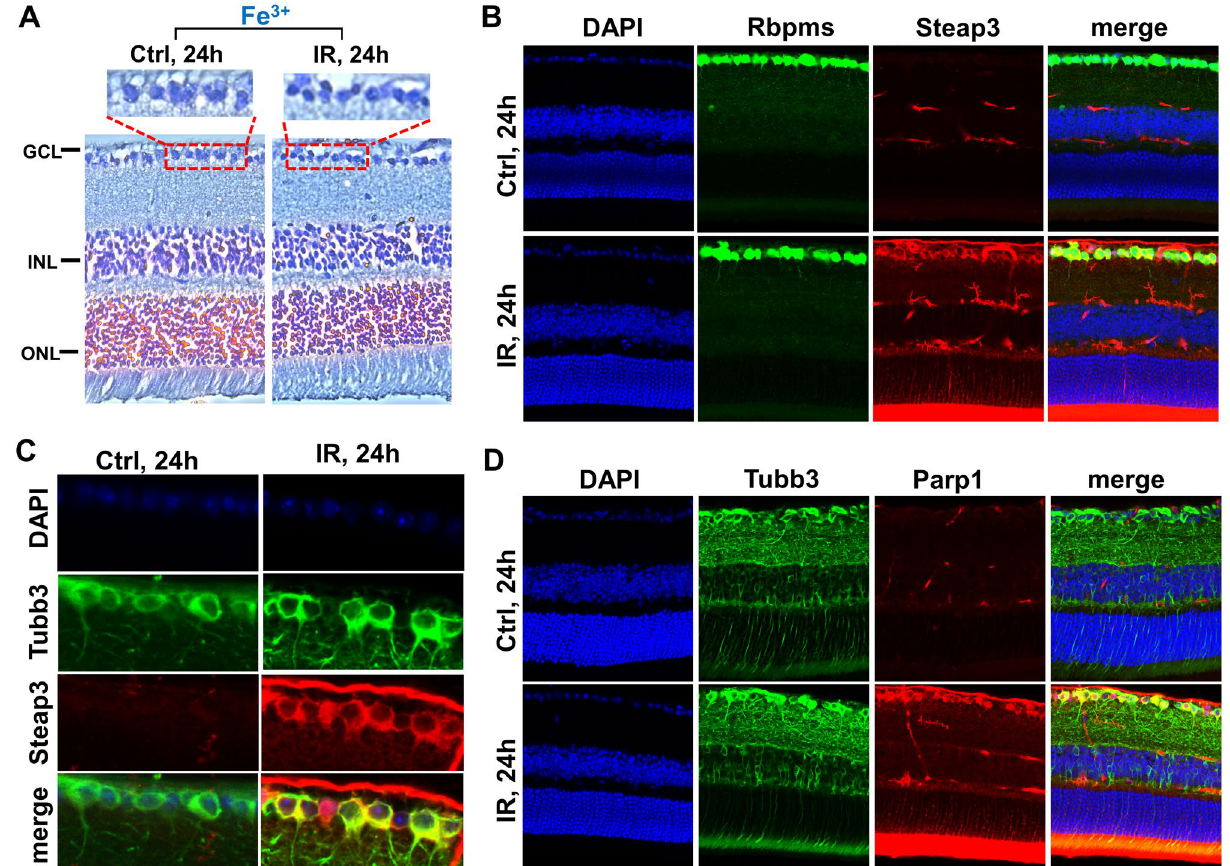
Figure 6. The expression of genes involved in oxytosis/ferroptosis, and parthanatos is significantly increased in ischemic RGCs. ( A ) Prussian blue stain indicates a high content of iron in neurons of ischemic and normotensive retinas. Prussian blue is specific for ferric iron (Fe3+). ( B , C ) Immunohistochemistry (IHC) analysis reveals that Steap3, the key enzyme generating ferrous (Fe2+) iron from ferric (Fe3+) iron, is highly expressed in the ischemic retina. Rbpms and Tubb3 are RGC markers. ( D ) IR results in high expression of Parp1 in